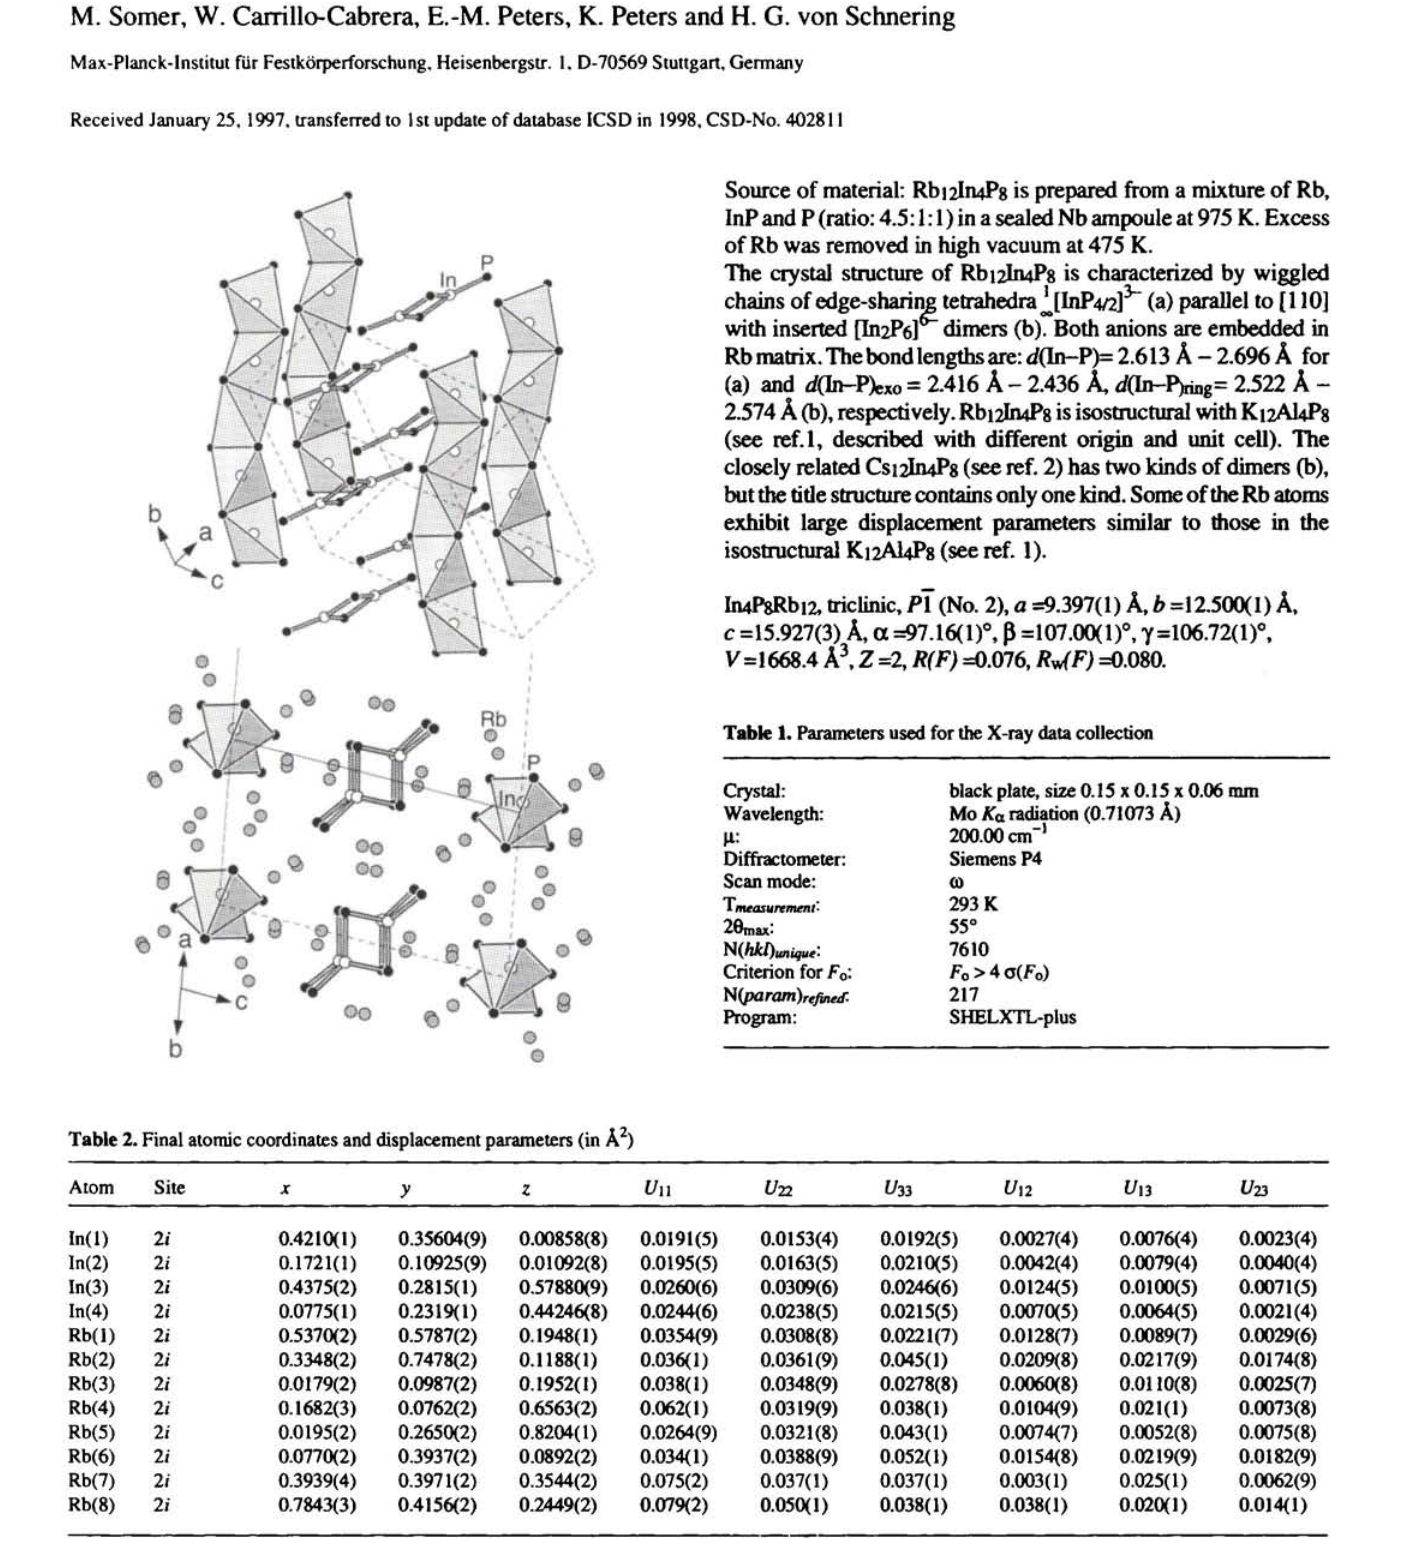
Table 2. Final atomic coordinates and displacement parameters (in